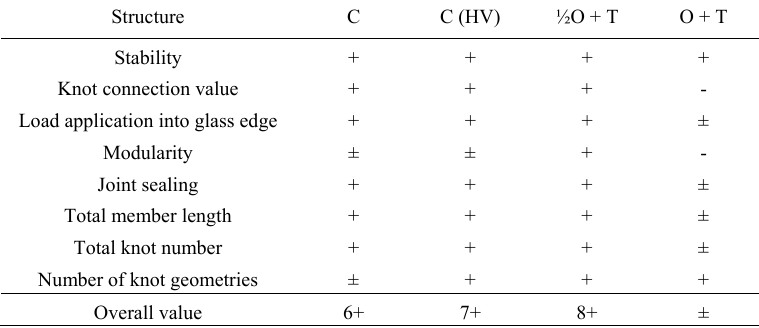
Table 7: Overall matrix of structural-constructive criteria